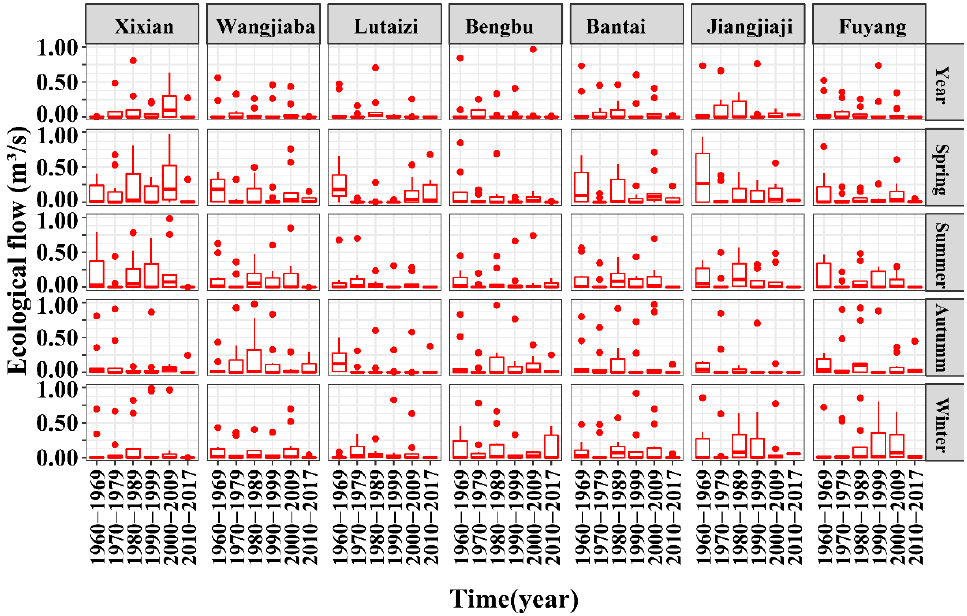
Figure 6. Change of the eco-deficit on the annual and seasonal scale.